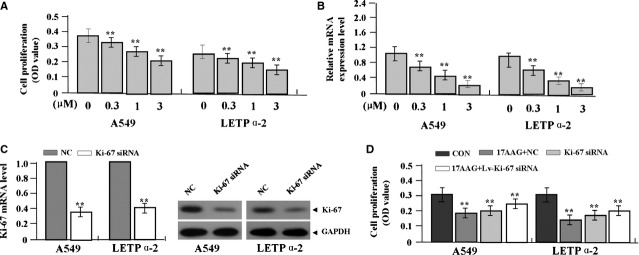
Effects of 17-AAG on cell proliferation. (A) 17-AAG diminished cell proliferative activities of LAC cells (A549 and LETPα-2) in a dose-dependent manner compared to the untreated group (each **P < 0.01). (B) The amount of Ki-67 mRNA, indicated by real-time PCR assay, was significantly reduced in a dose-dependent manner in 17-AAG treated groups compared to the untreated group (**P < 0.01). (C) After Lv-Ki-67-siRNA was transfected into LAC cells for 24 hrs, the expression level of Ki-67 mRNA and protein was markedly knocked down. (D) Cell proliferation was significantly repressed in 17-AAG+NC group compared to the 17-AAG+Lv-Ki-67-siRNA, Lv-Ki-67-siRNA and CON groups (**P < 0.01).